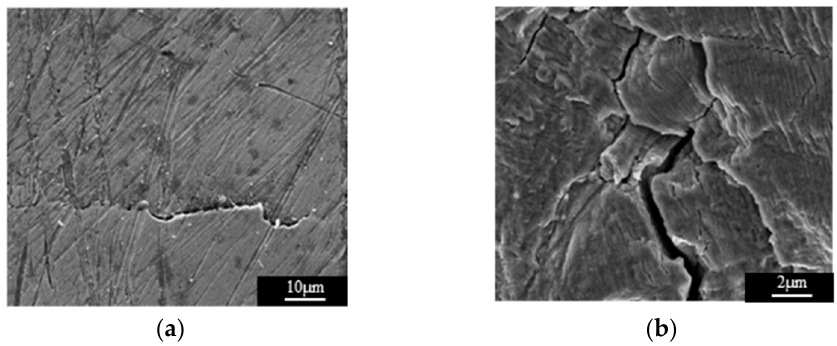
Figure 15. The SEM photographs of the SLM 316L stainless steel specimens subjected to different fatigue cycles. ( a ) Specimen C5 (50,000 times). ( b ) Specimen C6 (68,920 times).